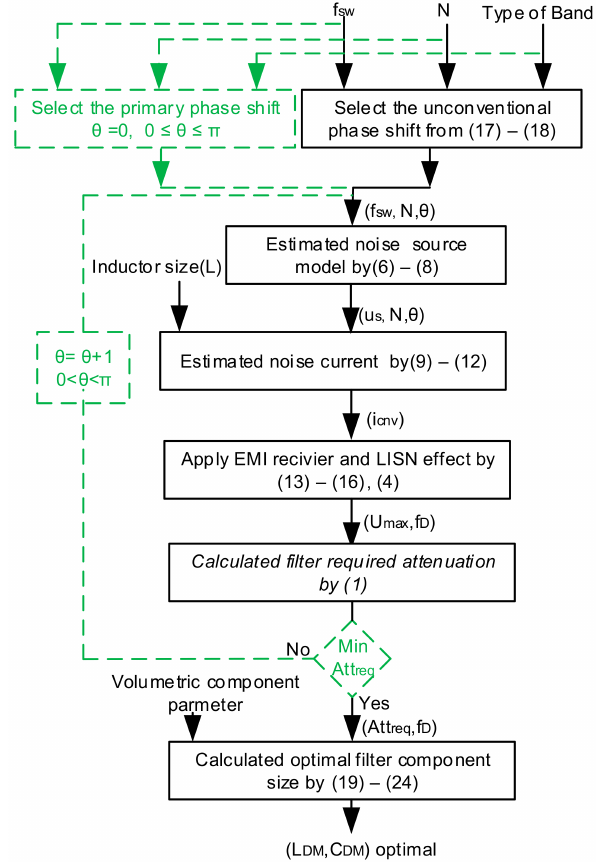
Figure 10. Flow chart of DM EMI filter boxed-volume